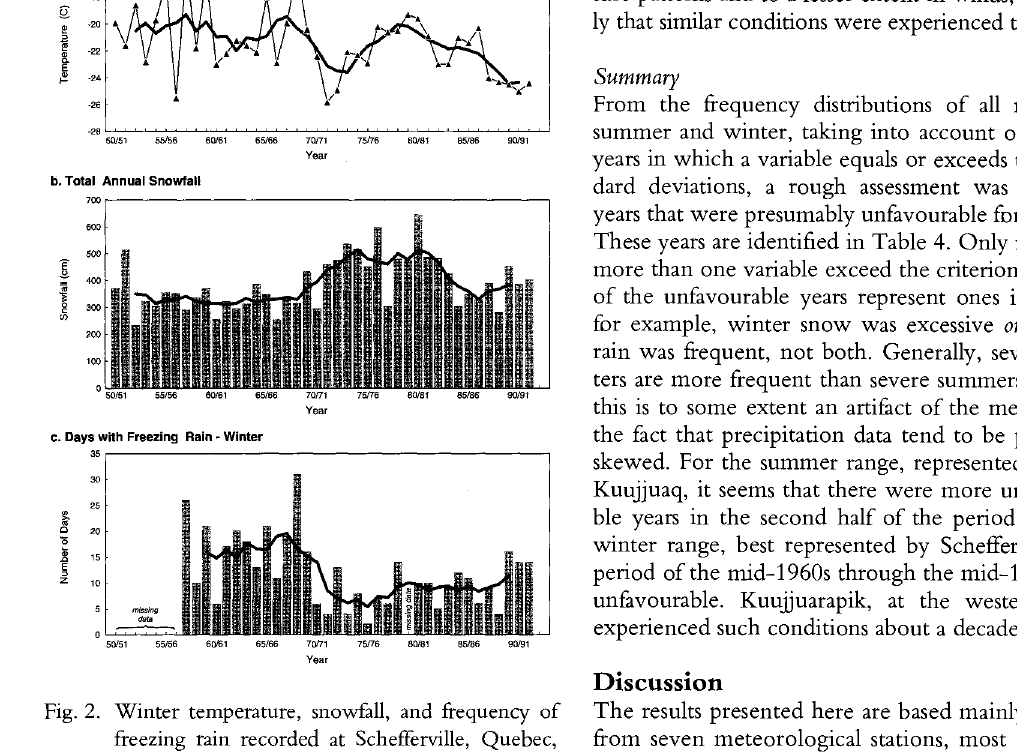
Fig. 2. Winter temperature, snowfall, and frequency of freezing rain recorded at Schefferville, Quebec, 1950-91, representing conditions on the winter range of the George River Herd.